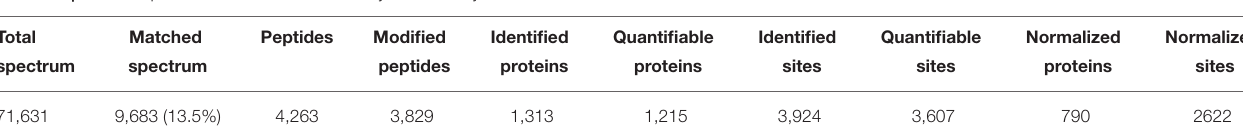
TABLE 1 | MS/MS spectrum database search analysis